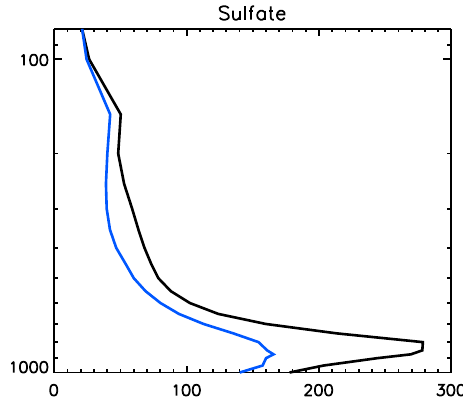
Figure 12. Profile of the daily (12 January 2005) mean mixing ra- tios (pptv) of sulfate simulated by the model in the larger grid (with a resolution of 50km × 50km) in S1_HighT (black) and in S0 (light